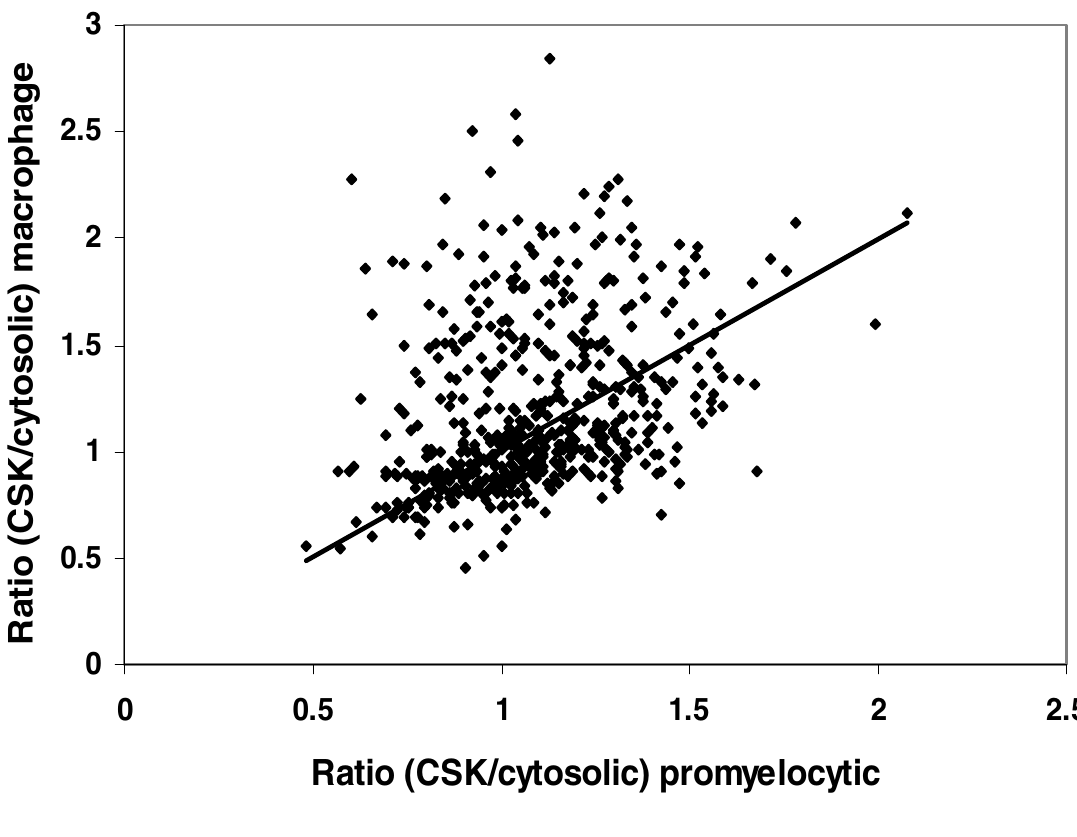
Effects of macrophage differentiation on mRNA distribution. Cytoskeleton-associated and cytosolic transcripts were isolated from HL-60 promyelocytic (precursor) cells and HL-60 differentiated to macrophage-like cells by phorbol ester induc- tion. Microarray hybridization measured the relative amounts of 5184 mRNAs in the cytoskeleton and cytosolic populations of untreated or differentiated cells. Each of the 649 points represents the ratio of a specific transcript in the cytoskeleton-associ- ated vs cytosolic fraction of the promyelocytic or differentiated cell type. Transcripts whose signal intensity was not above the background noise level were removed prior to